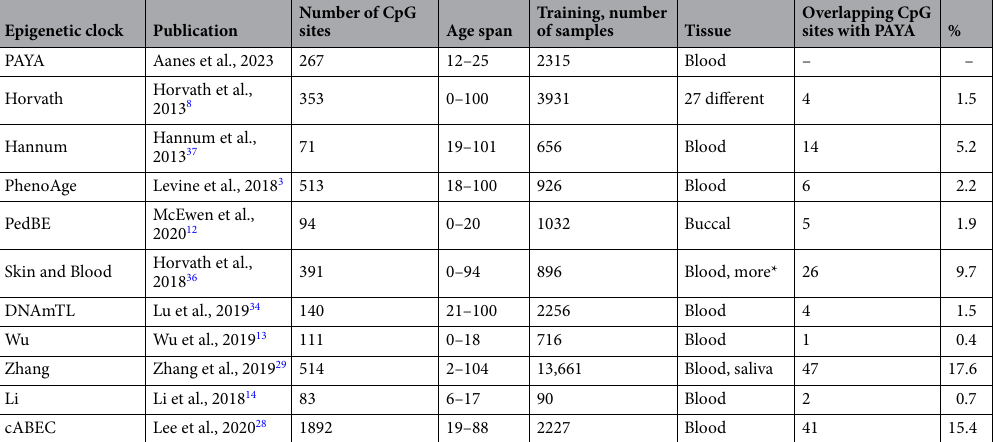
Table 1. Overview of epigenetic age predictors and the overlap in CpG sites compared to PAYA (Predictor of Adolescents and Young Adults). *Human fibroblasts, keratinocytes, buccal cells, endothelial cells and